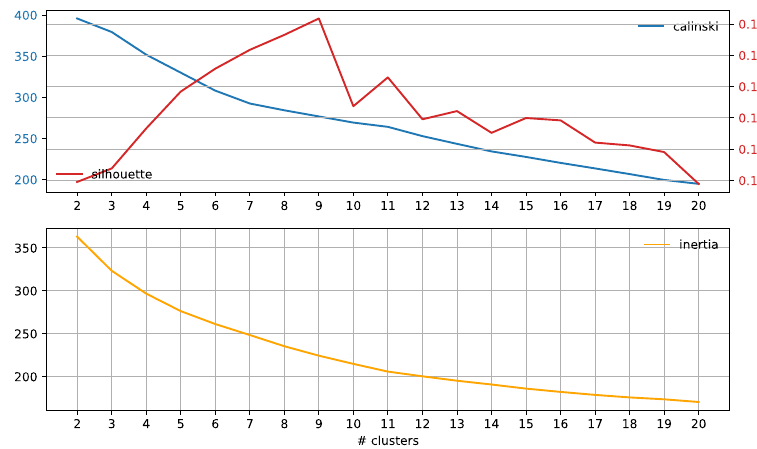
Figure A21. Subreddit Sciatica.